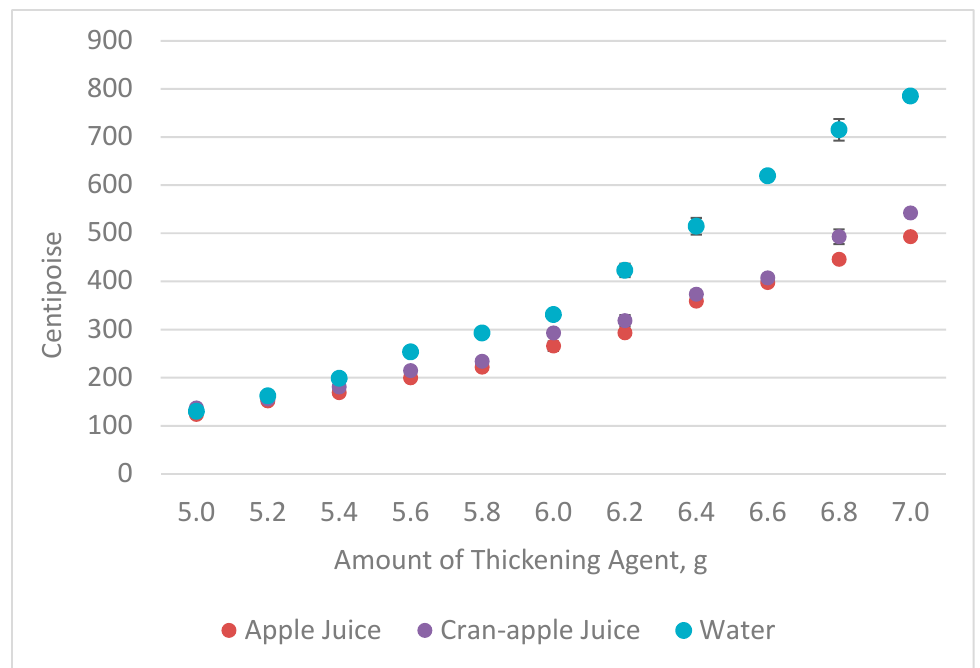
Figure 2. Viscosity measurements for the incremental changes in the amount of instant thickening agent (Error bars show the standard error for each mean).